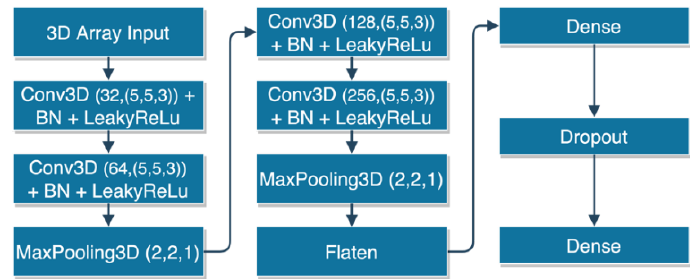
Figure 6. Our 3DCNN structure.